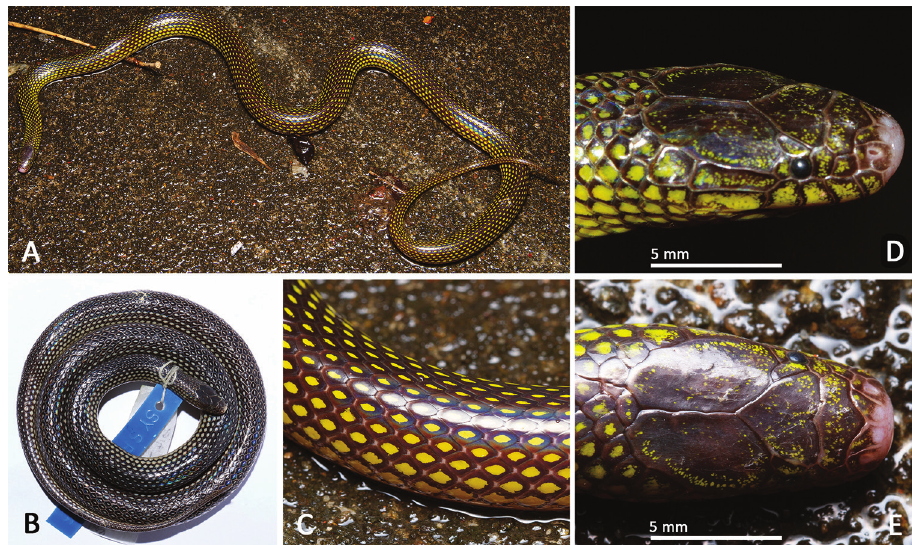
Figure 4. Morphological features of the adult male holotype SYS r00946 of Opisthotropis hungtai sp. nov. A Habitus view in life B habitus view in preservative C close-up of mid-dorsal body D–E close-up of head scales. Photos by Jian Zhao and Jian